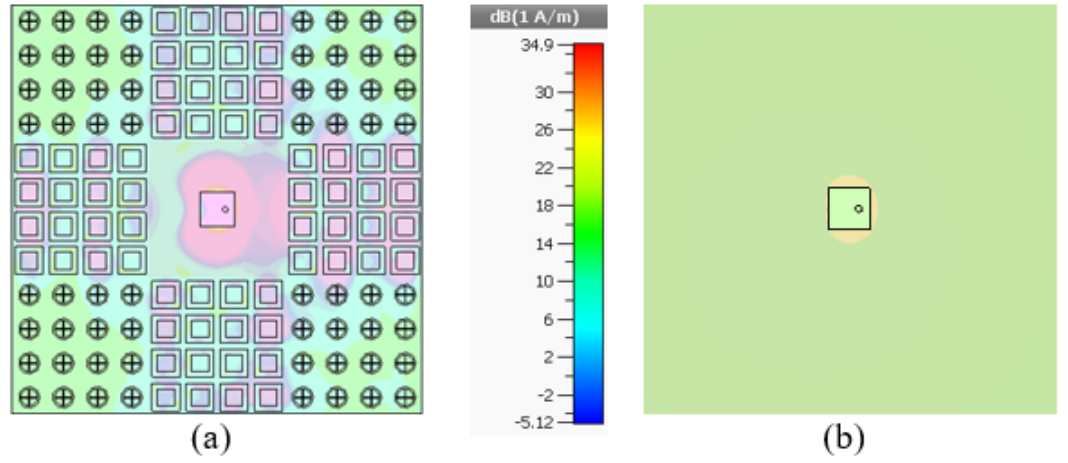
Figure 8. Current distribution on proposed and reference antenna at 7.6 GHz. ( a ) proposed antenna. ( b ) reference antenna.